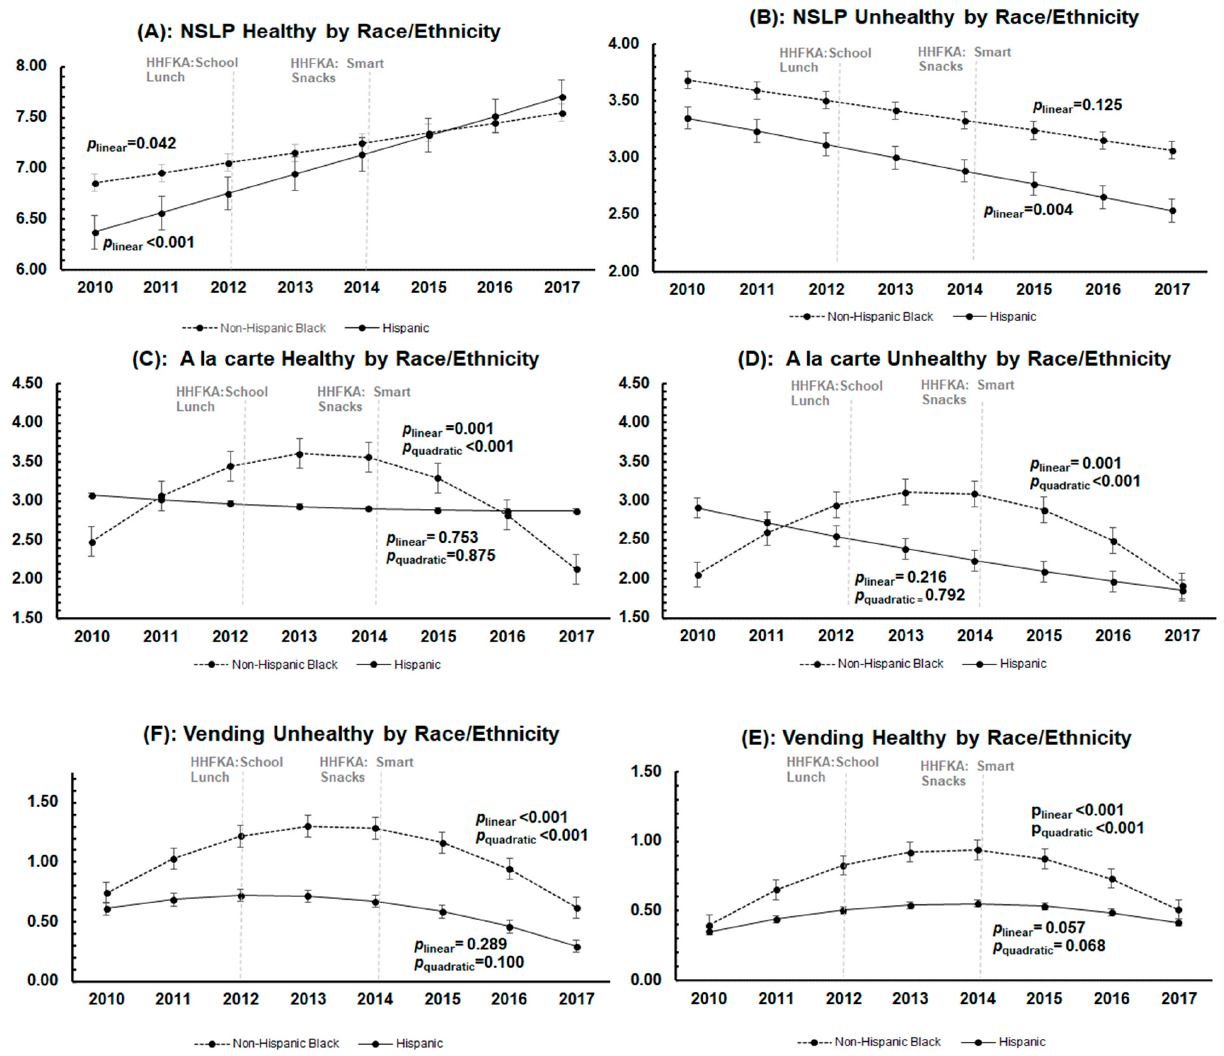
Figure 2. Year-by-year point estimates and predicted trends of each of the six food environment indices from school year 2010-11 to 2017-18 by race/ethnicity. Dots represent the adjusted point estimates with confidence intervals estimated from the multilevel multivariable linear regression model. Lines represent the predicted line of best fit over the study period. The 2012 vertical line represents the implementation of the Healthy Hunger-Free Kids Act (HHFKA) guidelines for NSLP that occurred in 2012. The 2014 vertical line represents the implementation of the Smart Snacks guidelines (within the HHFKA) that occurred in 2014.